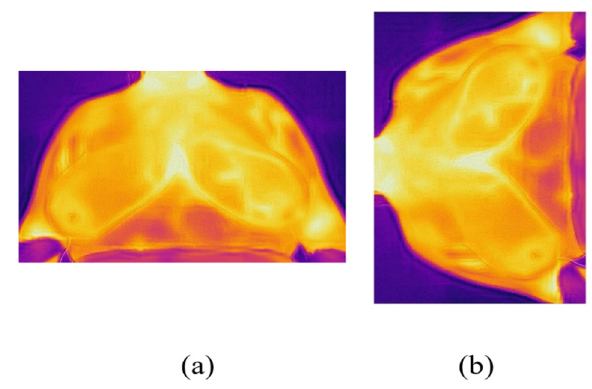
Figure 13. ( a ) Original Thermal Image from Shiraz Medical Center for Breast Cancer & ( b ) Tilted Thermal Image.